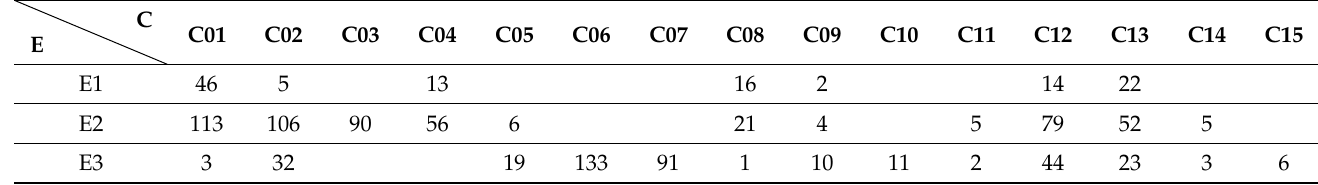
Table 6. Matrix of numerical relation between type of element and type of